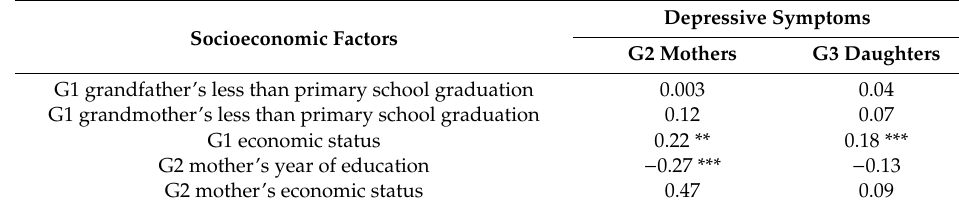
Table 2. Bivariate relationship between socioeconomic factors and depressive symptoms controlling for covariates (each regression coe ffi